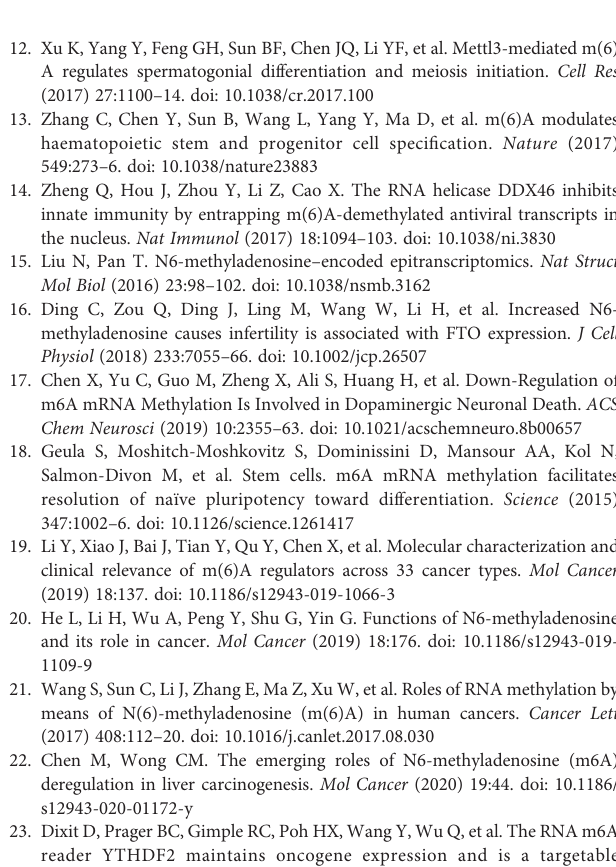
Supplementary Table 1 | Information on thirty-three cancer types from the